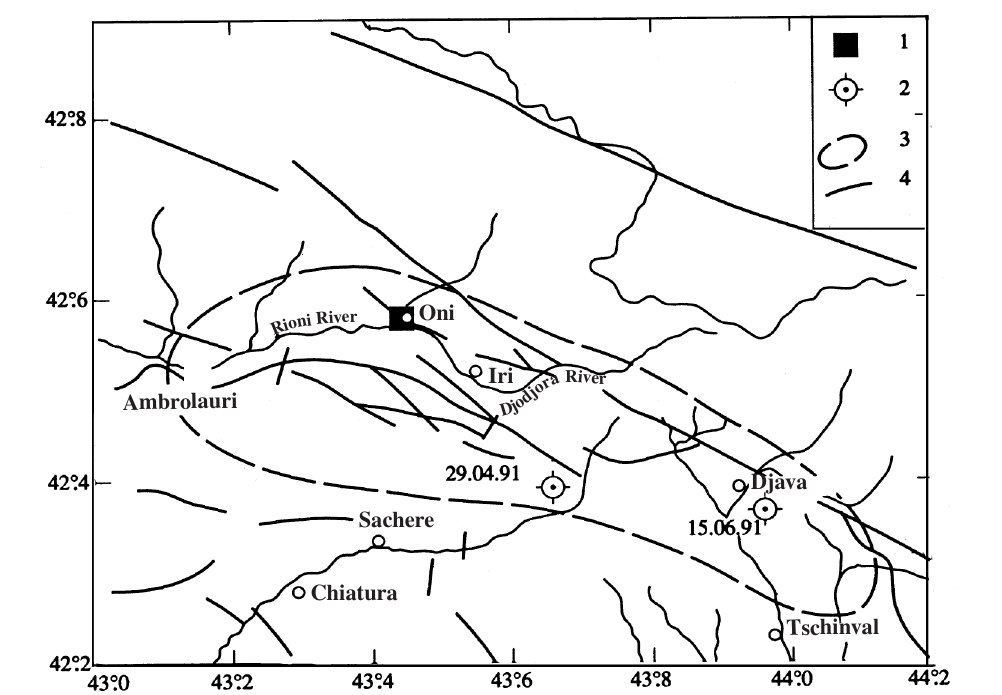
Fig. 1. The epicentral zones of the Racha-Djava earthquake (29.04.1991, M = 6.8) and the strongest aftershock (15.06.1991, M = 6.3). Here (1) is the point of observation, (2) indicates the epicenters, (3) is the pleistoseist zone, and (4) indicates the